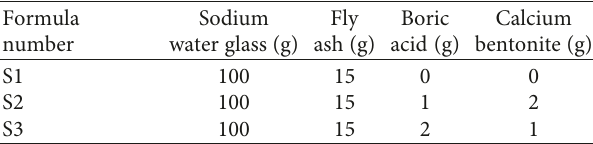
Table 3: Experimental formula.